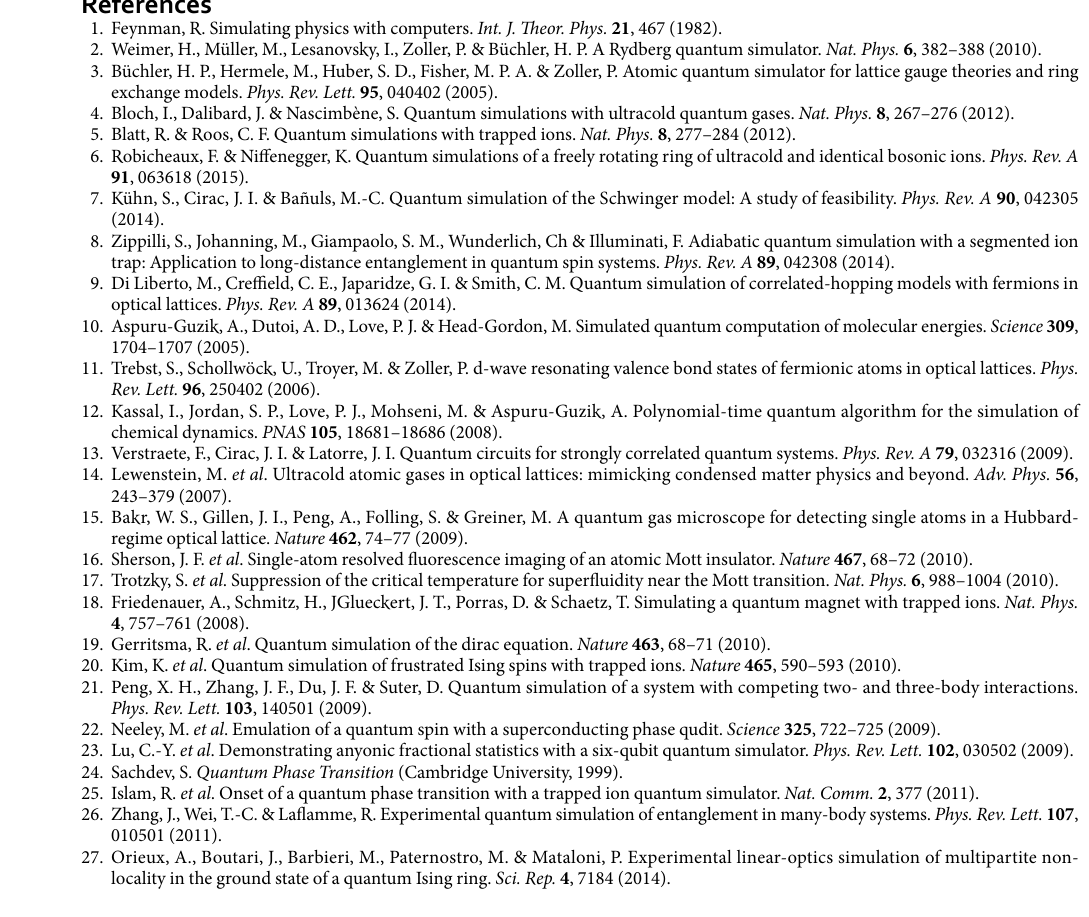
5 Scientific RepoRts | 7: 2183 | DOI:10.1038/s41598-017-02571-w